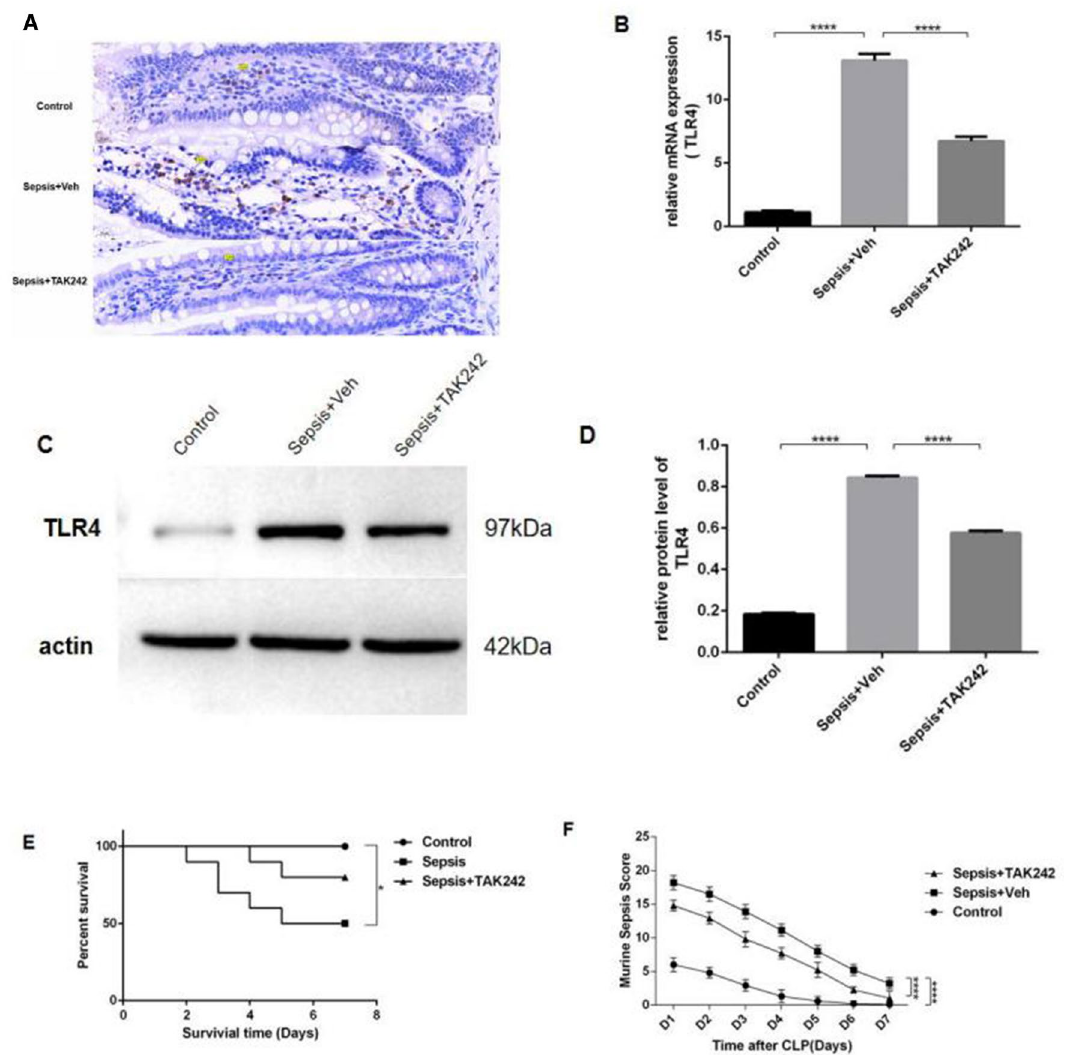
Figure 1. TLR4 was upregulated after cecal-ligation and puncture (CLP) induced sepsis in mouse from which small intestine, as demonstrated by ( A ) immunohistochemical, ( B ) real-time PCR and ( C, D ) westrenblotting for TLR4. CLP induced sepsis led to ( F ) reduced survival and ( E ) higher sepsis severity score (n = 10 mice). Error bars denote standard error of the mean. * P < 0.05; ** P < 0.01; *** P < 0.001; **** P <